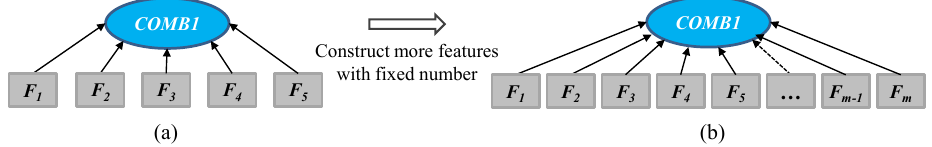
Figure 4. The new GP tree representation with COMB1 as a root node produces a predefined number of features by extending the width of the tree: using COMB1 to produce five features ( a ); and using COMB1 to produce m features ( b ). F i denotes a subtree that produces a feature using functions (e.g., arithmetic operators) and terminals.